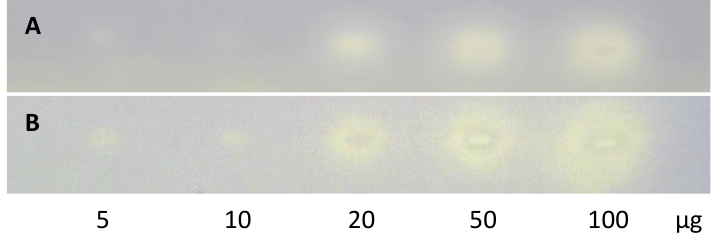
Figure A2. COX-2 TLC assay with increasing quantities of ( A ) celecoxib and ( B ) diclofenac.